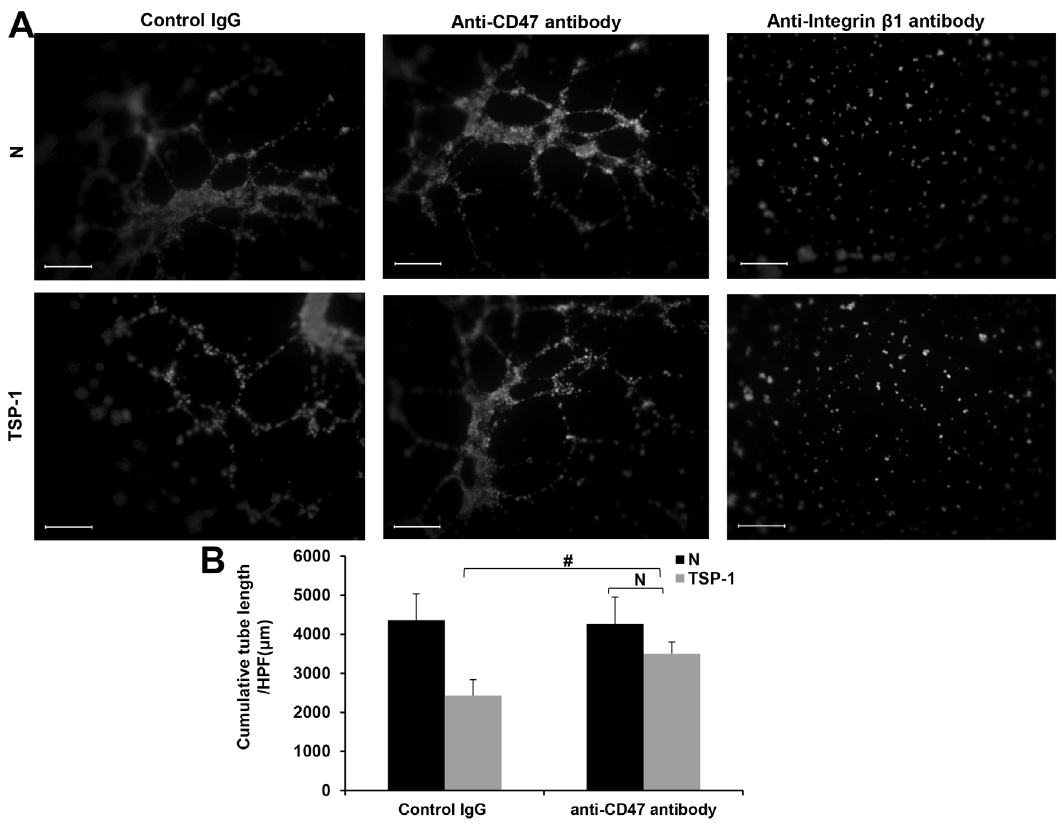
Figure 5. CD47 antibody attenuated TSP-1 9 s inhibition on angiogenesis of late EPCs. (A) Late EPCs were plated on Matrigel and treated with anti-CD47 antibody (2.5 m g/ml), anti-integrin b 1 antibody (2 m g/ml) or control IgG for 30 min and then treated with TSP-1(2 m g/ml) as described (Scale bar=400 m m, 50 6 magnification). (B) Total tube length per HPF (100 6 magnification) was measured. Values are presented as the mean 6 S.D. of three independent experiments ( # p , 0.05 versus control siRNA with TSP-1